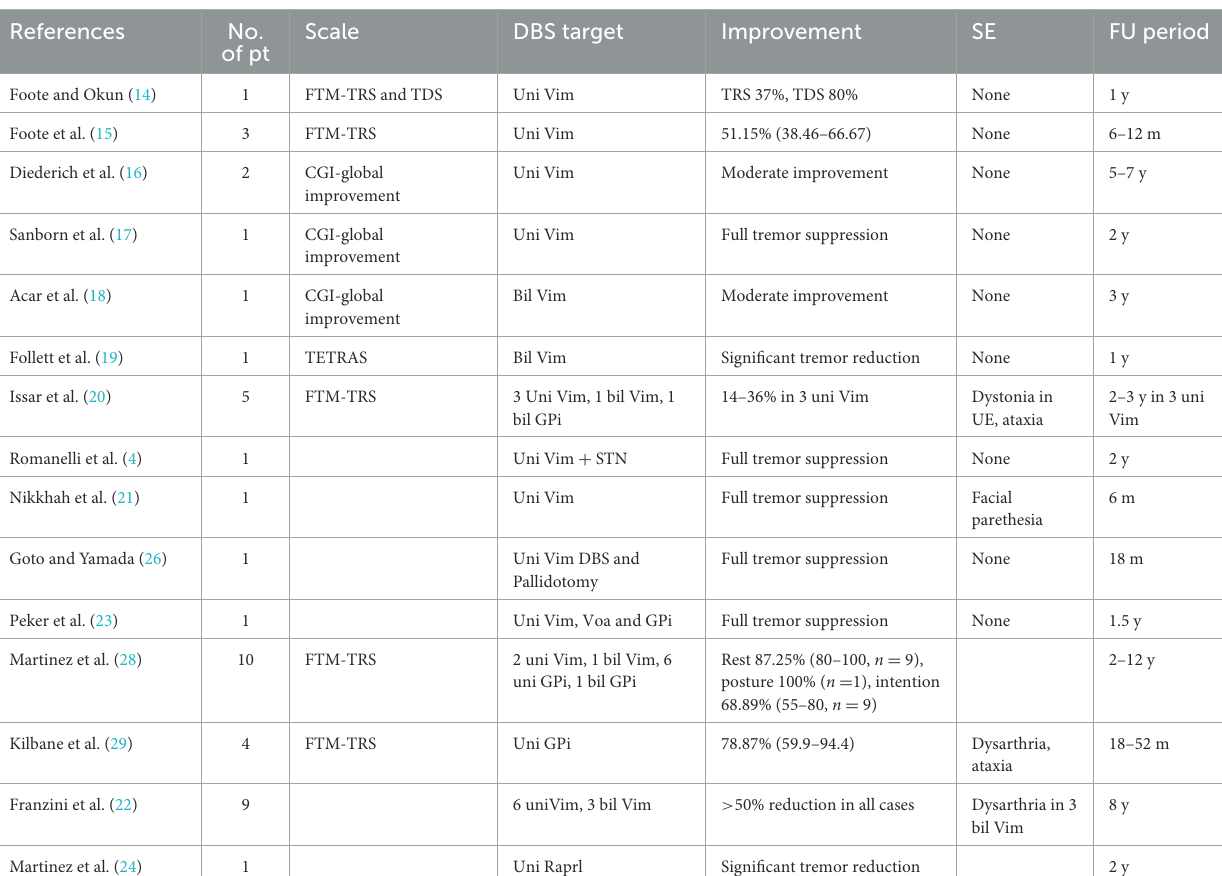
TABLE 2 Clinical outcomes of other DBS targets for